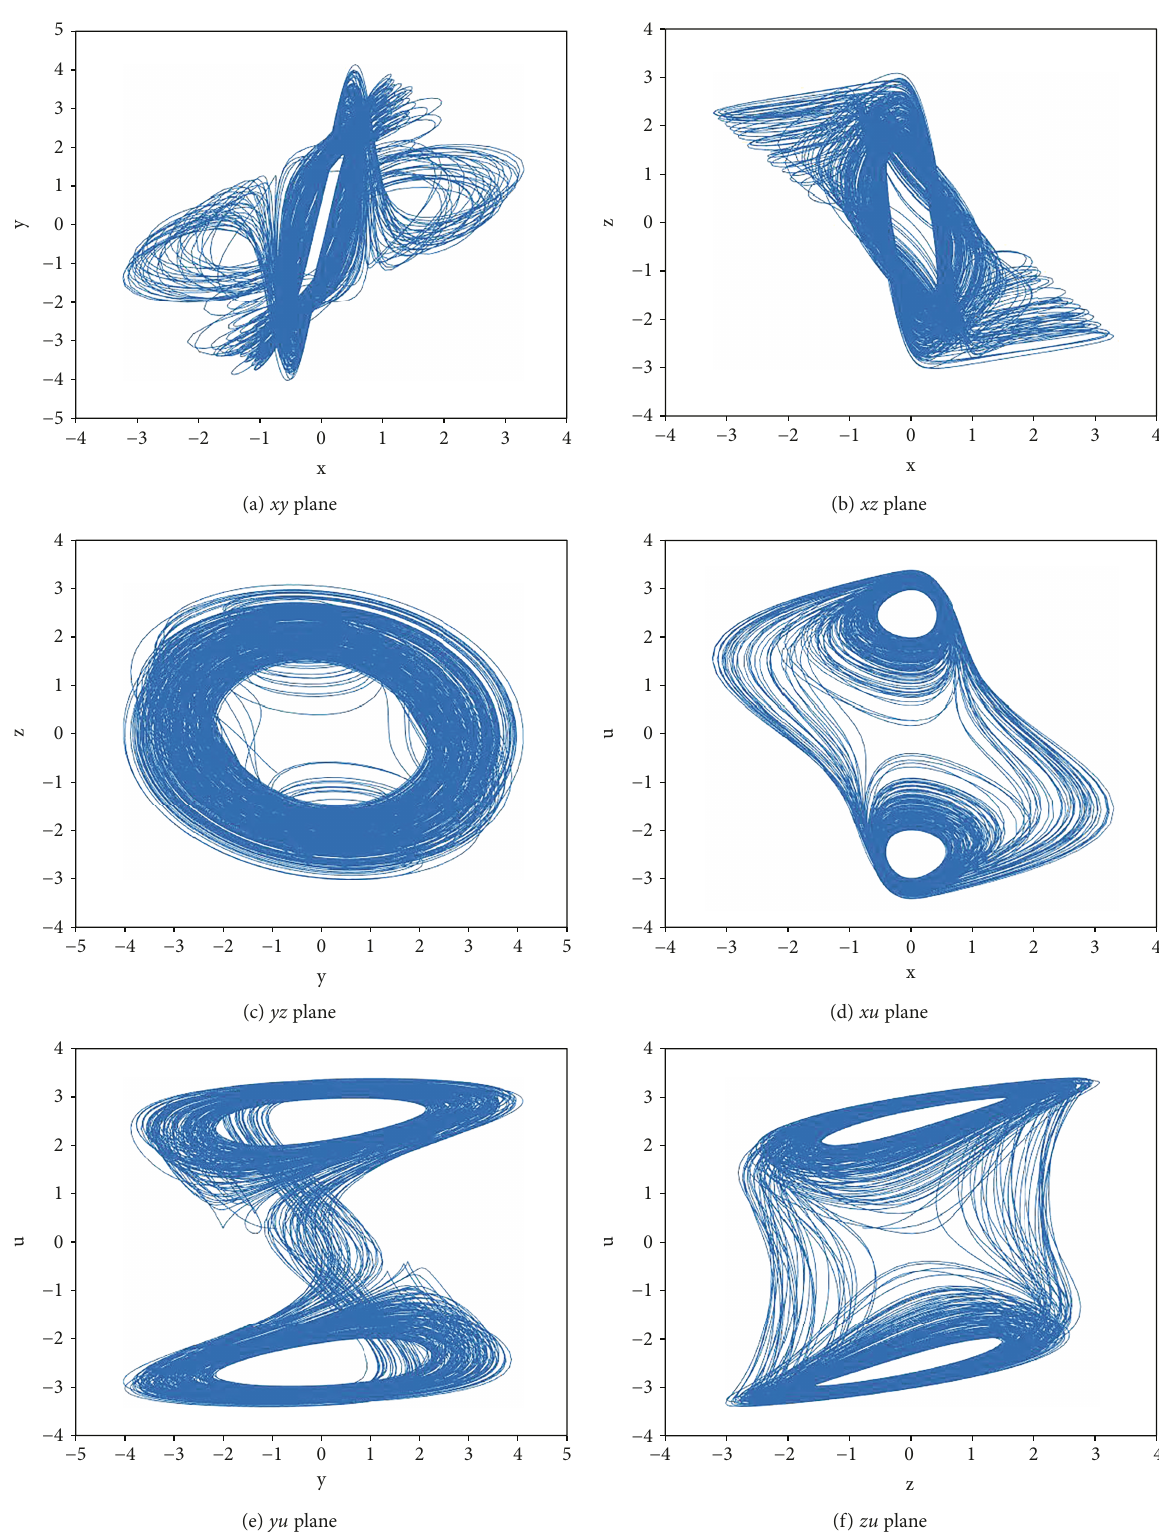
Figure 3: The chaotic attractors of system (24) with